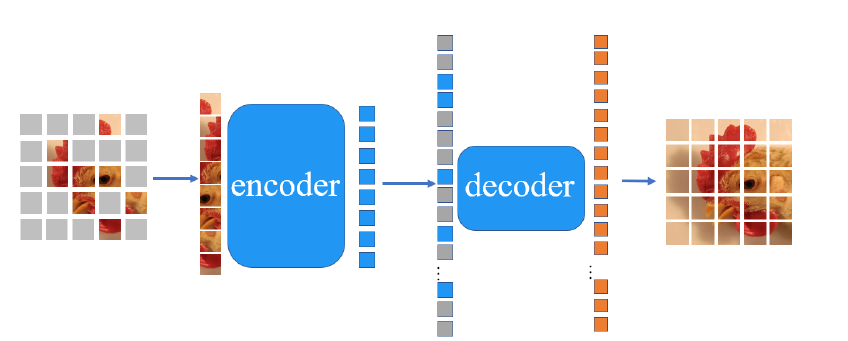
Figure 4. The asymmetric encoder–decoder structure of MAE. The image is masked, and the un- masked patches are input into the encoder. The encoder codes them into more patches and delivers them to the decoder to reconstruct a whole unmasked image.